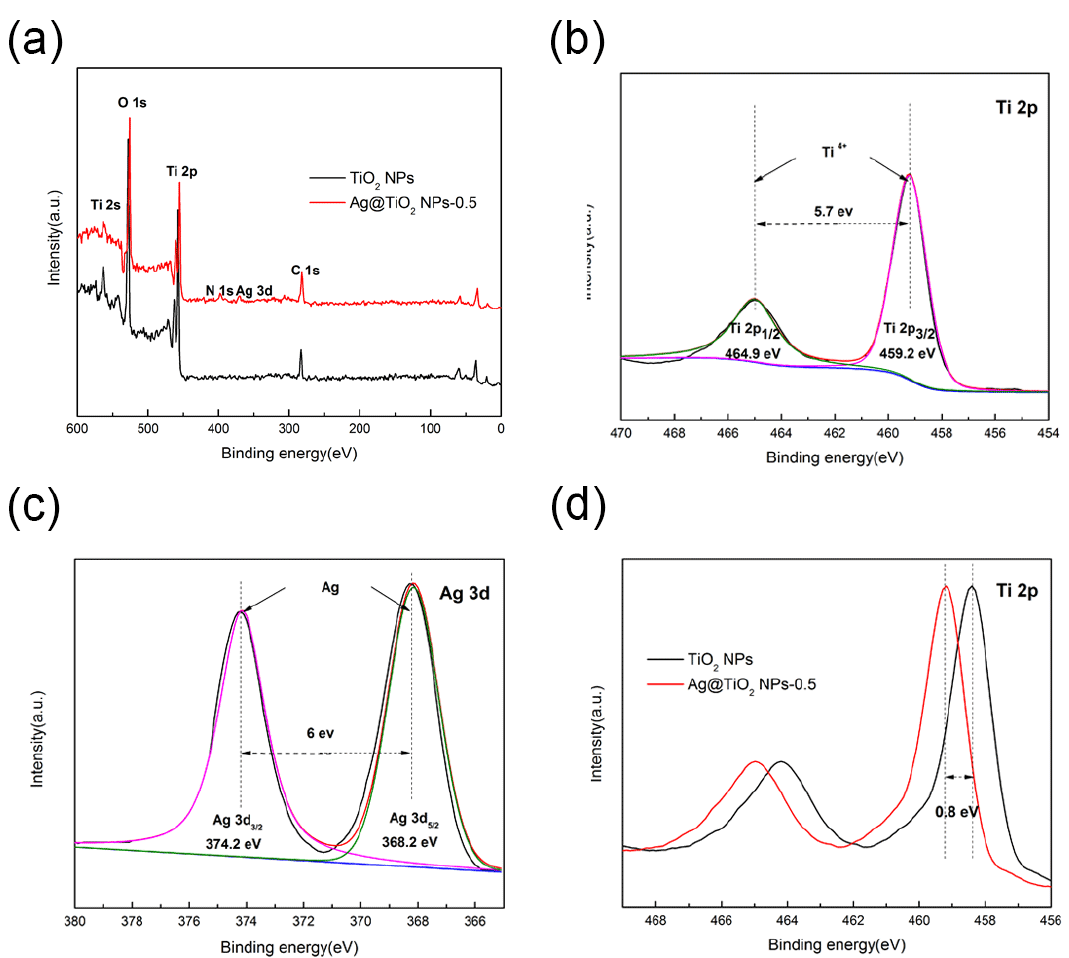
Figure 4. XPS spectrum of TiO 2 NPs and Ag@TiO 2 NPs-0.5 ( a ); high resolution spectra of Ti 2p ( b ); Ag 3d ( c ); Ti 2p of TiO 2 NPs and Ag@TiO 2 NPs-0.5 ( d ).